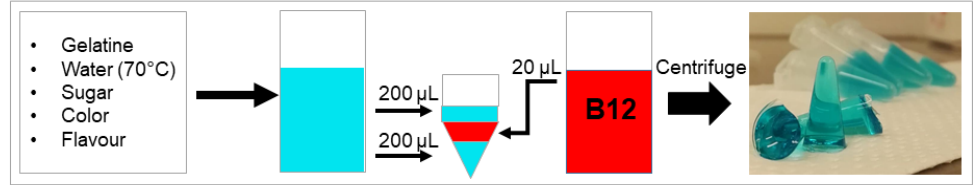
Figure 2. Jelly beans with CN-B12. To mimic a daily vitamin pill, B12 was embedded in a jelly matrix. The rats in the two supplementation g roups, “CN - pill” (0.72 µg CN - B12/day) and “CN -pill (4× )”